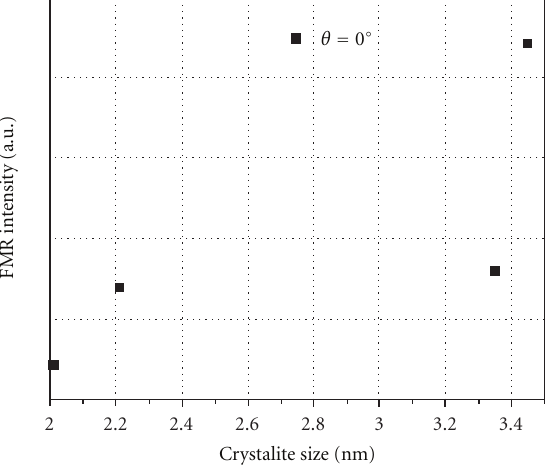
F 3: FMR intensity as a function of crystallite size of the thin �lms.